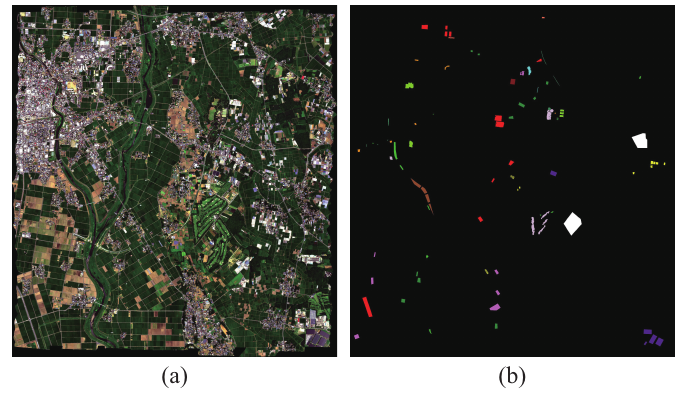
Figure 9. Chikusei data set. ( a ) Pseudocolor image. ( b ) Ground-truth map. Table 2. The selected bands on the source data sets via graph-representation-based band selection (GRBS). Kennedy Space Center (KSC). The Selected